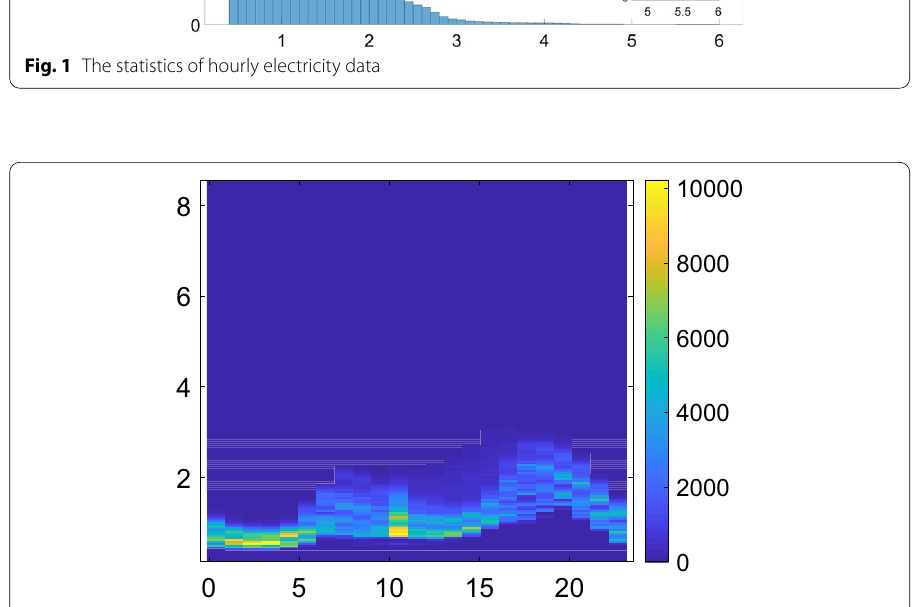
Fig. 2 The distribution of hourly electricity